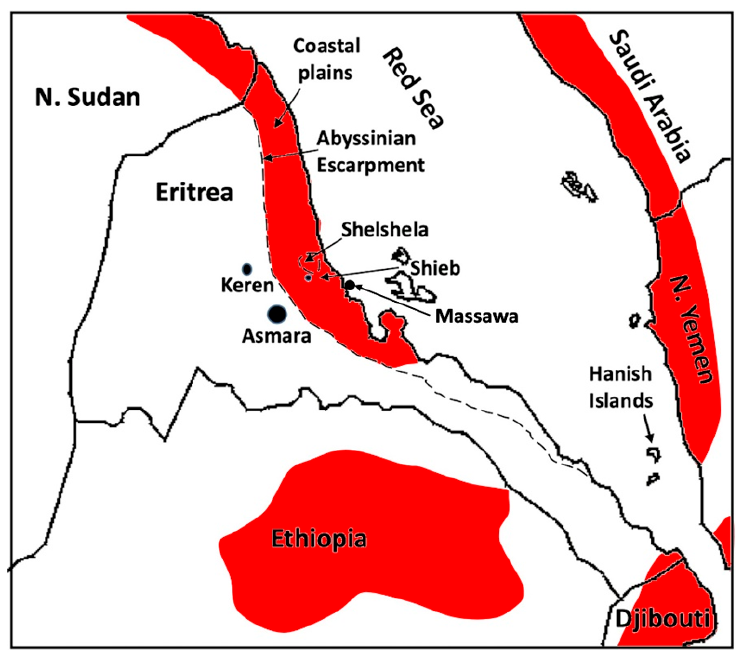
Figure 5. Locations and regions mentioned in the text in relation to desert locust activity and insecurity in Eritrea. Primary breeding areas in red.